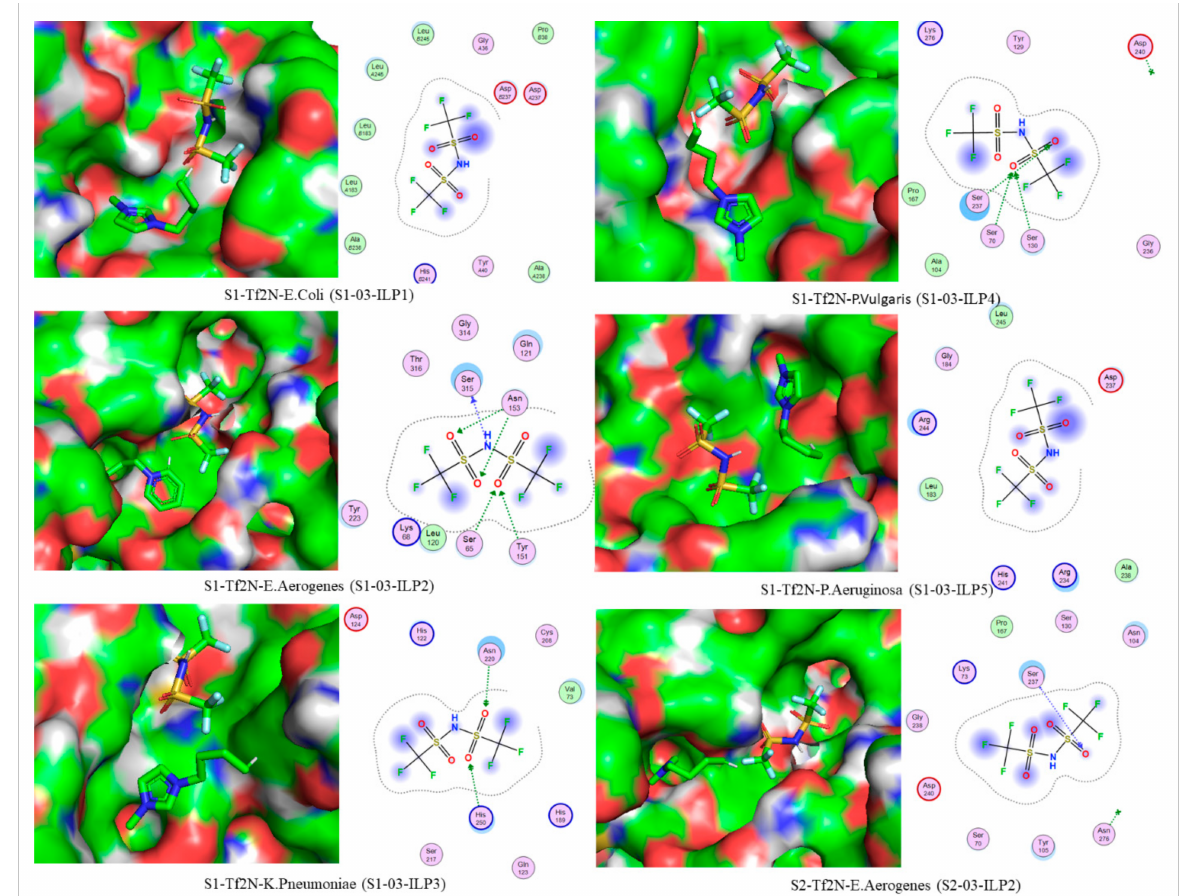
Figure 2. Docked sites of ILs with Tf2N − against six bacterial